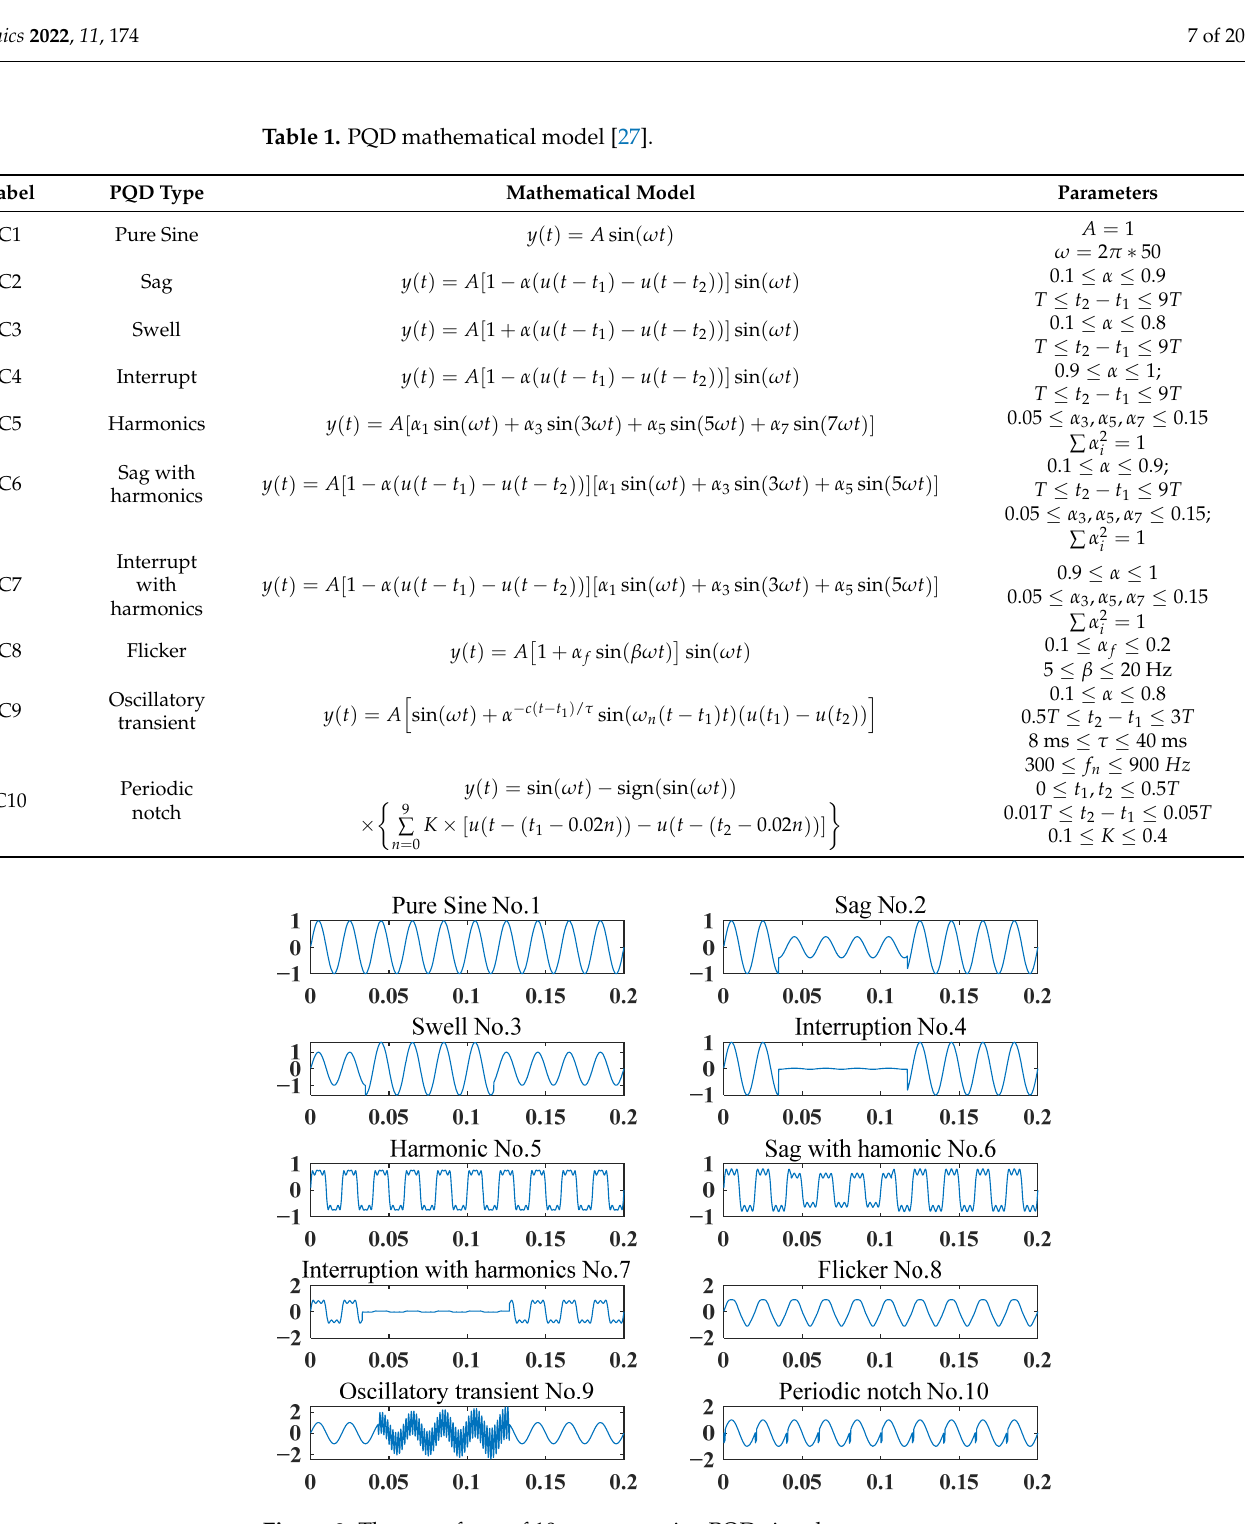
Figure 3. The waveform of 10 representative PQD signals.